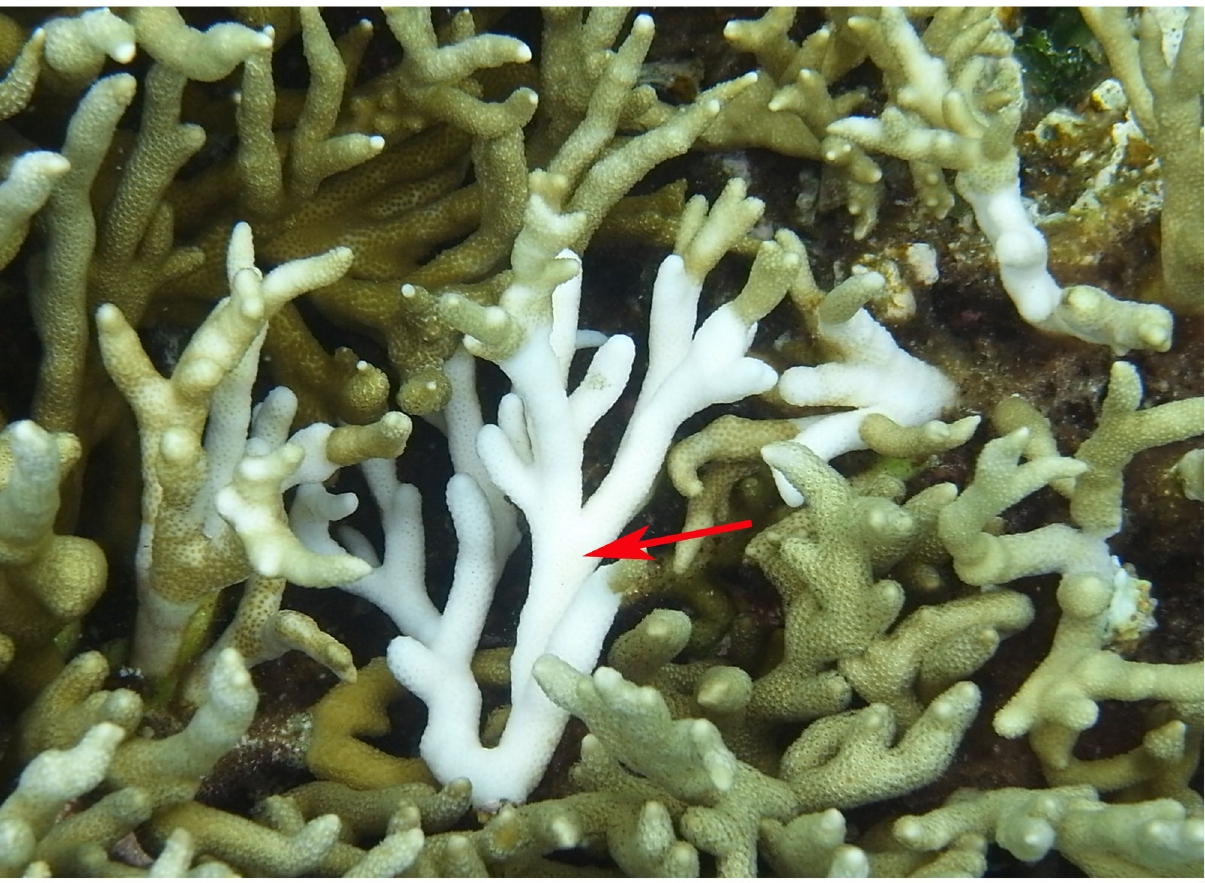
Figure 1. White syndrome of Porites andrewsi . Colony showing typical signs of PAWS at Nanshazhou Lagoon. The central colony (arrowed) exhibits severe tissue loss, where nearly the whole skeleton was denuded very recently (bright white). The size of the tissue loss area of the central individual was greater than those of surrounding